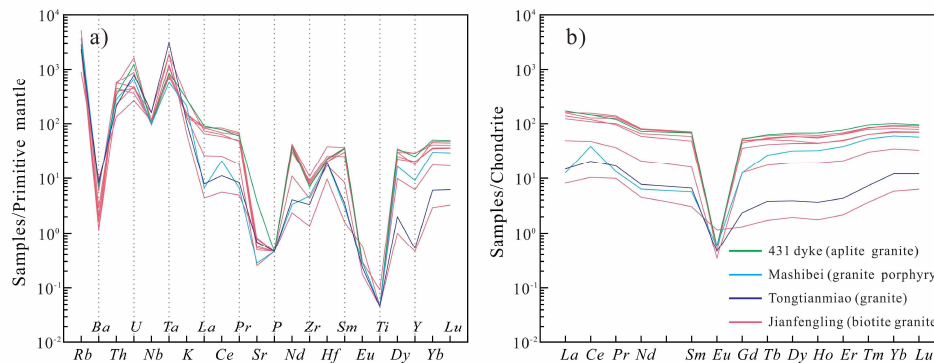
Figure 7. ( a ) The primitive mantle normalized diagram of trace elements [38] and ( b ) the chondrite- normalized REE patterns [39].